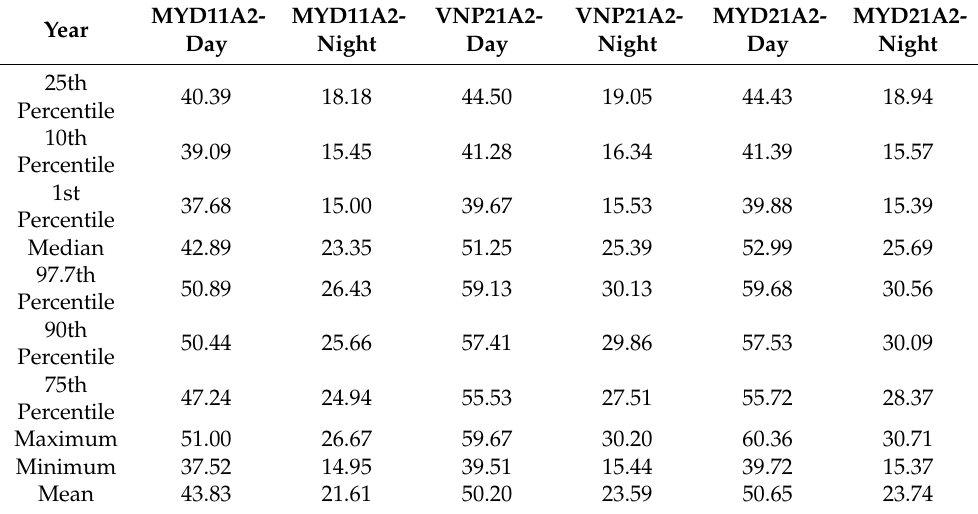
Table 5. Kimberley 2019 monthly data by percentile. The 97.7th percentile is commonly used as an indicator of the level at which “outlier” values should be removed from the